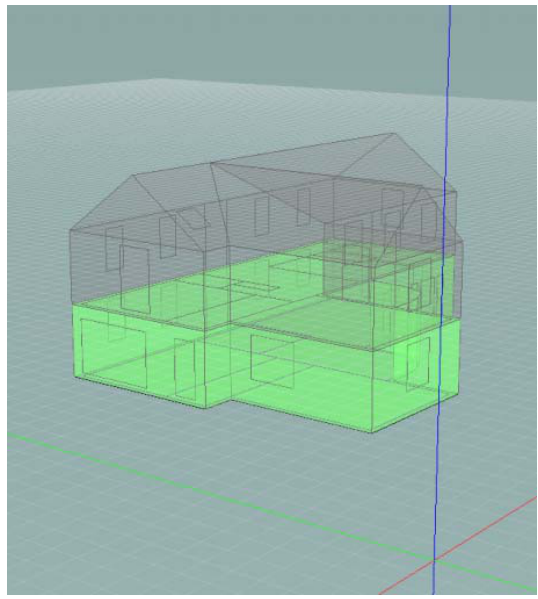
Figure 6. Geometric modeling with the 3D module in the EPC software of Belgium Government [35].